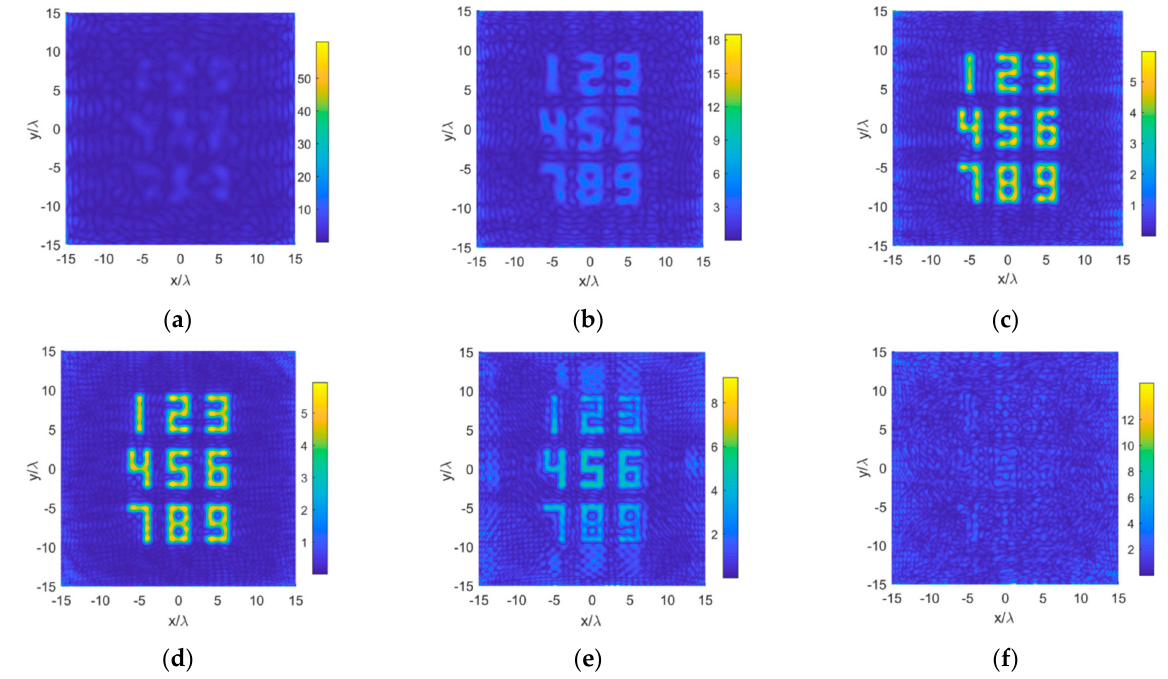
Figure 10. Reconstructed results for Case 3. Sample on a planar grid above the source with different θ s ,max : ( a ) 15 ◦ ; ( b ) 25 ◦ ; ( c ) 35 ◦ ; ( d ) 45 ◦ ; ( e ) 55 ◦ ; and ( f ) 65 ◦ .